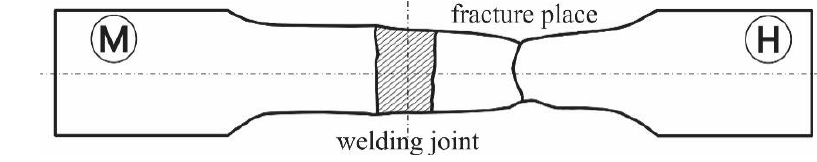
Figure 9 – Test tube 1.1 after tearing Рис. 9 – Эпроветка 1.1 после